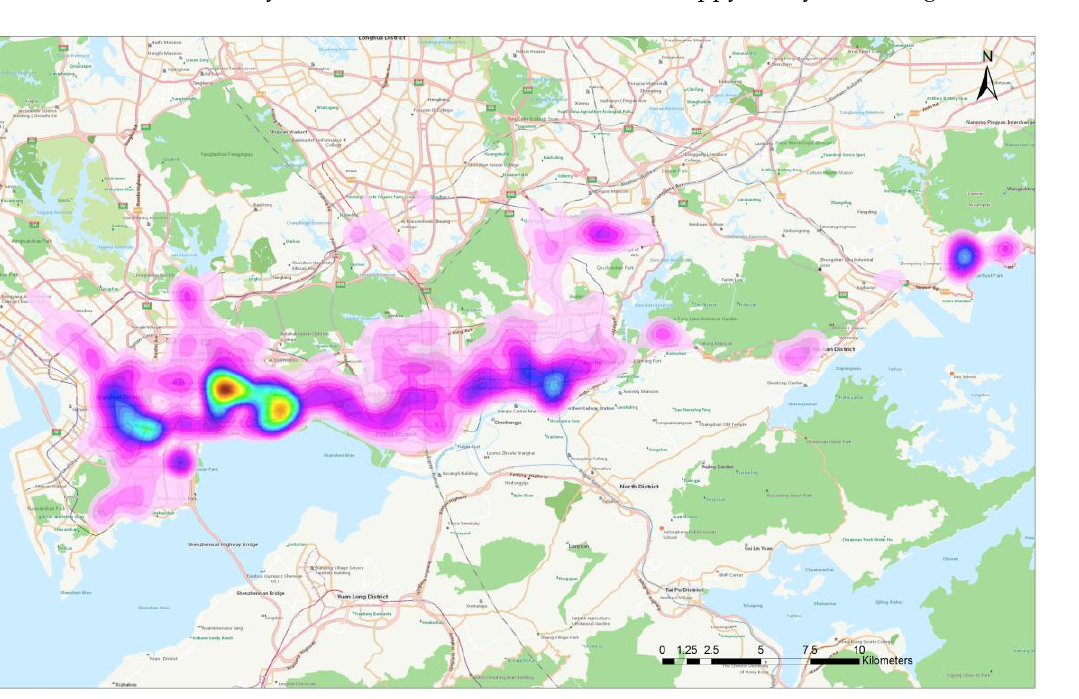
Figure 6. Density distribution of travel